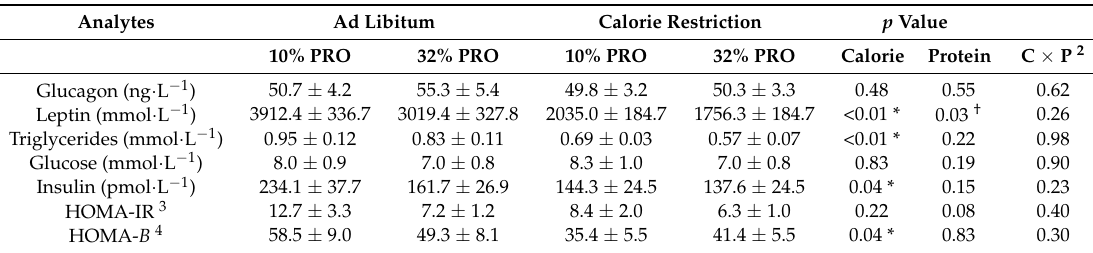
Table 1. Circulating Metabolic Profile 1 .